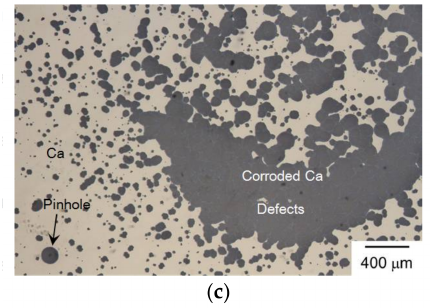
Figure 12. Corroding of a Ca sensor covered by a barrier film after tensile bending of a 20-mm curvature radius for 1000 h: ( a ) as attached; ( b ) after 610 h; ( c ) OM micrograph of Region 1 in ( b ).